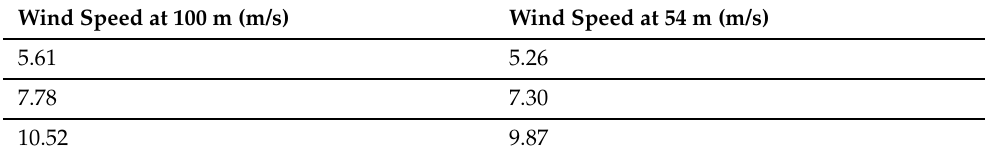
Table 8. Values of wind speed at 54 m.